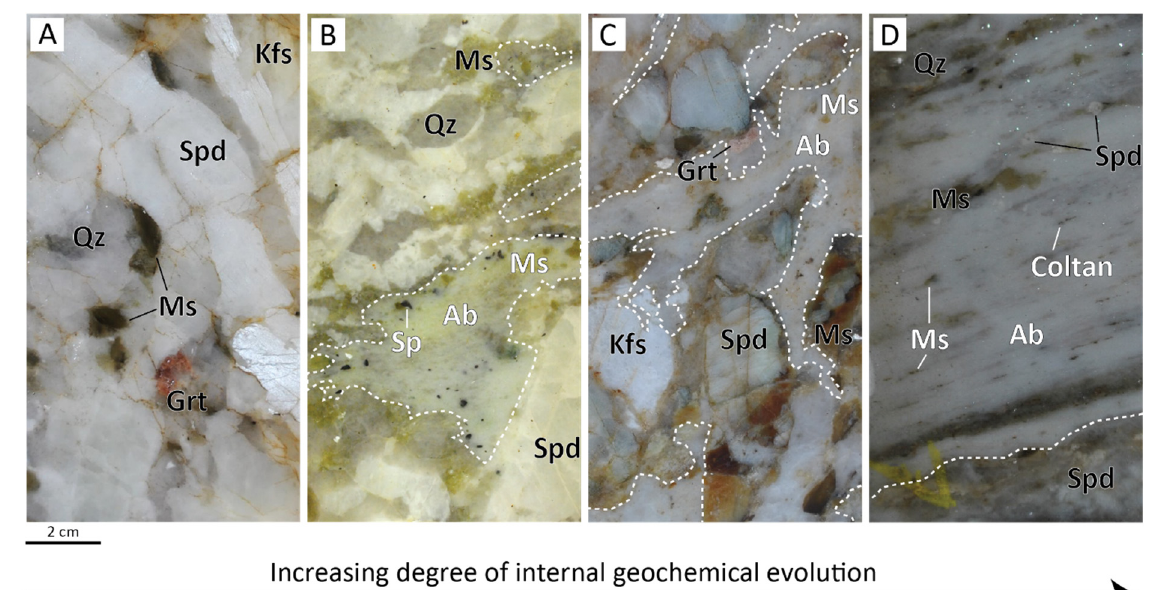
Figure 3. Representative textures indicating the internal evolution of spodumene pegmatites in Aclare; the same evolution is observed in Moylisha. Mineral abbreviations: Ab = albite, Coltan = columbite-tantalite group minerals, Grt = garnet, Kfs = K-feldspar, Ms = muscovite, Qz = quartz, Sp = sphalerite, Spd = spodumene. ( A ) Typical early primary assemblage with no albitization. ( B ) Early primary assemblage with patches of late primary albitite. ( C ) Interconnected albitite patches with visible alteration of early primary assemblage. ( D ) Predominant late primary albitite with relics of spodumene, quartz and muscovite. Extent of albitization is represented by white dashed lines. Scale bar is valid for all images.